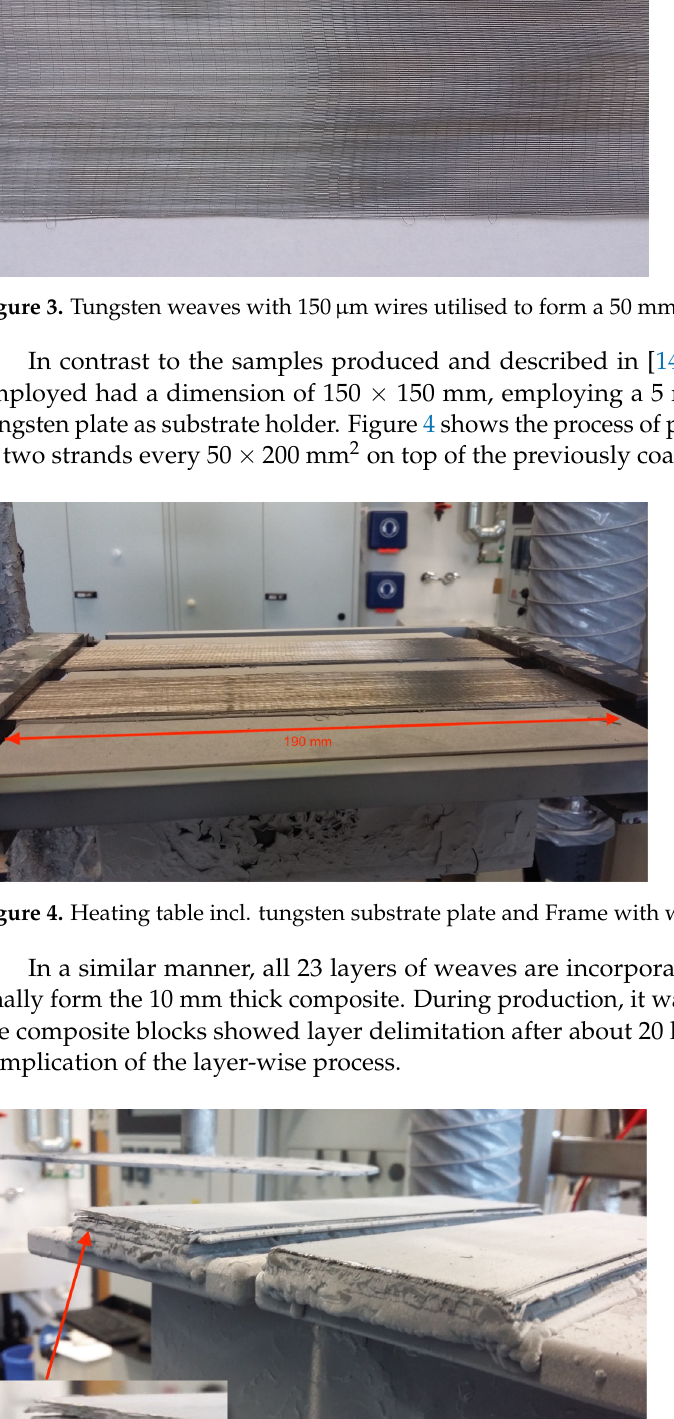
highest quality areas. Areas with lower quality were used to cut smaller samples.